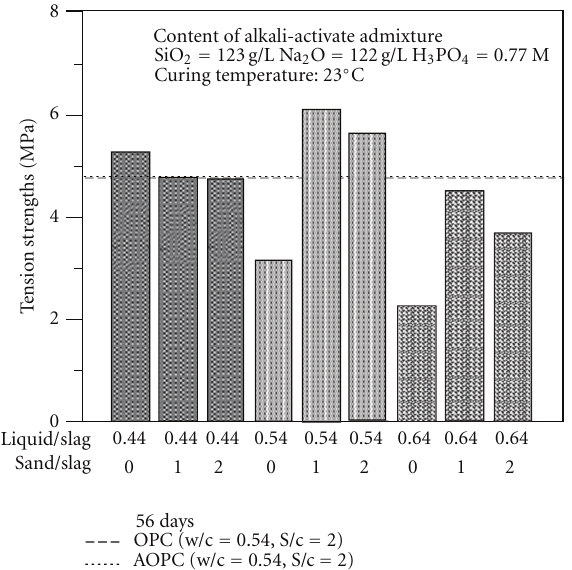
Figure 8: Tensile strength of AAS mortars at the age of 56 days.